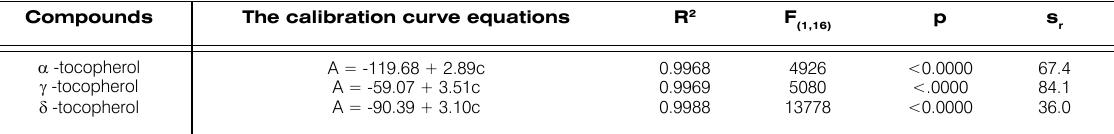
Table 2. The equations of calibration curves used for tocopherols quantification